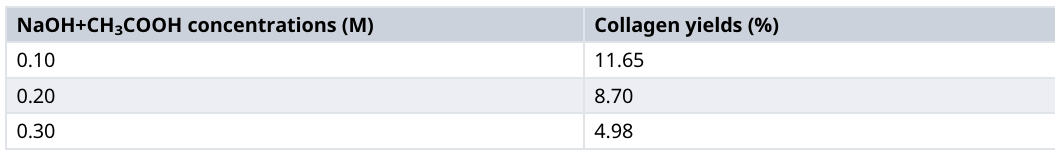
Table 3. The yield of isolated collagen with NaOH and CH 3 COOH variations NaOH+CH 3 COOH concentrations (M)